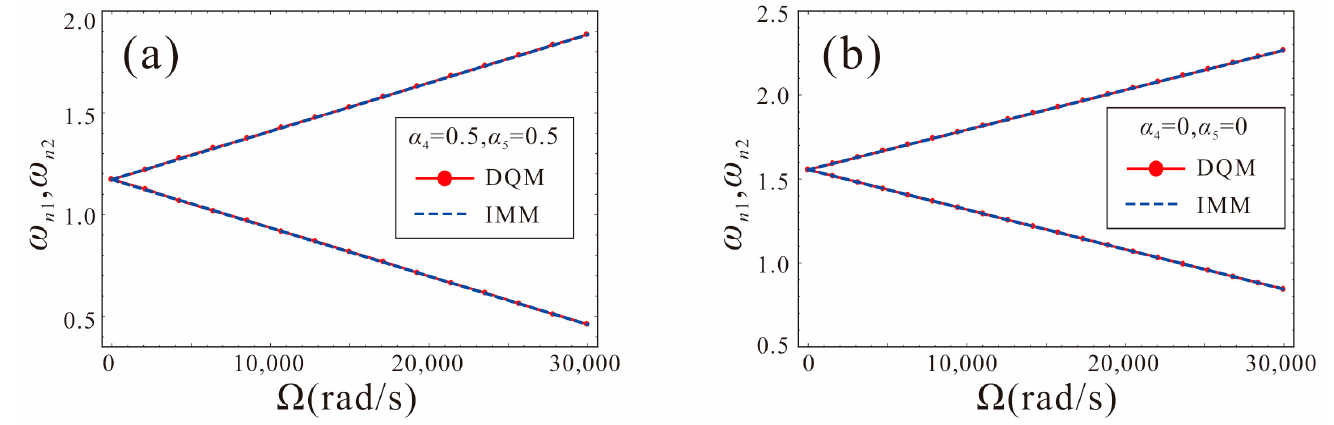
Figure 12. Comparison between numerical solution of DQM and analytical solution of IMM: ( a ) shape factors are α 4 = α 5 = 0.5; ( b ) shape factors are α 4 = α 5 = 0. ( a ) shape factors are α 4 = α 5 = 0.5; ( b ) shape factors are α 4 = α 5 =